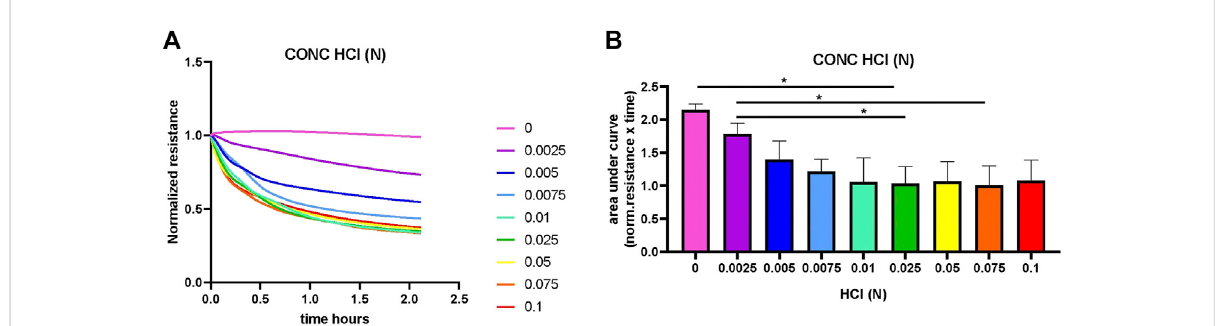
Dissolving of CAP by titration of HCl concentration. HCl was added in increasing concentrations to dissolve the calcium phosphate coating (CAP) on electrodes containing 96-well plates. Resistance was measured by ECIS at a frequency of 64 kHz for 2 hours. (A) . Overview of the normalized resistance for all HCL concentrations. In control with no HCl, CAP coating is not lysed and resistance not changed. The higher HCL concentrations had dissolved the CAP coating already at very early time points. (B) . Quanti fi cation of area under the curve shows signi fi cant differences (* p < 0.01 n = 3).